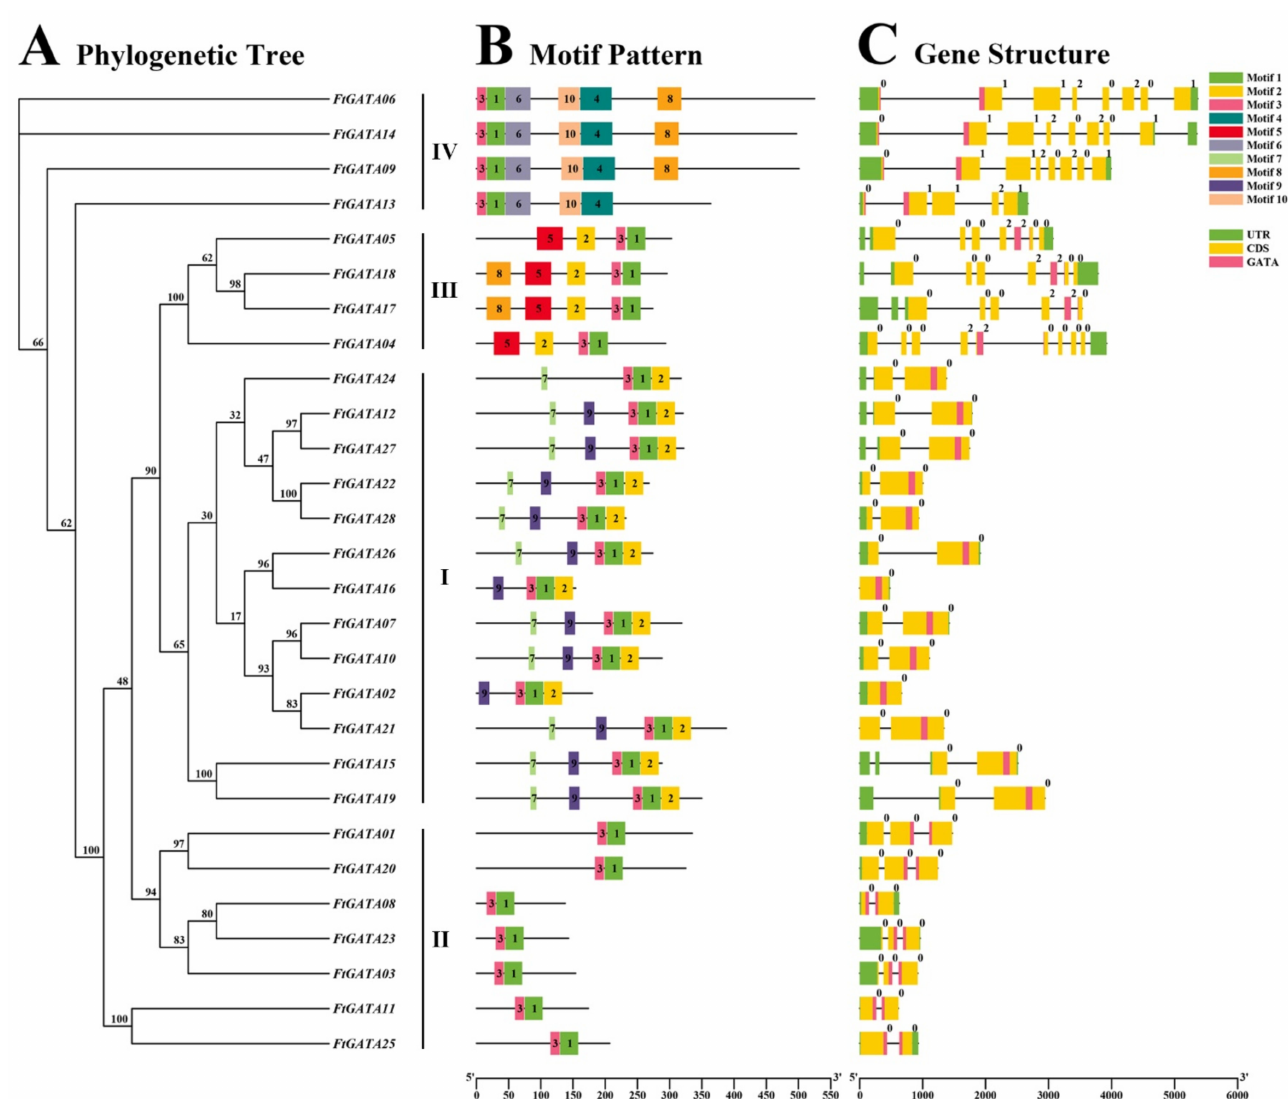
Figure 2. Phylogenetic relationships-, motif distributions-, and gene structure of GATA genes in Fagopyrum tataricum . ( A ) The phylogenetic tree was constructed with 1000 replicates on each node. ( B ) The 1–10 amino acids motifs in FtGATAs protein are represented with ten different colored boxes, and black lines represent relative protein length. ( C ) The UTR (untranslated region), CDS (coding sequence), GATA domain, and introns are indicated by green squares, yellow squares, pink squares, and black lines,